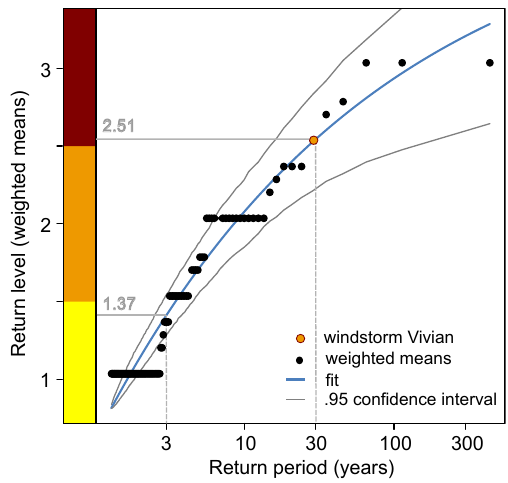
Figure 4. Return level plot using the weighted means of the CAT- DAM classification (dots), e.g., the weighted mean for windstorm Vivian (orange dot) is 2.5. Grey horizontal lines indicate recalcu- lated return levels as a function of return periods of 3 and 30 years (grey dotted vertical lines). Filled boxes are as in Fig.